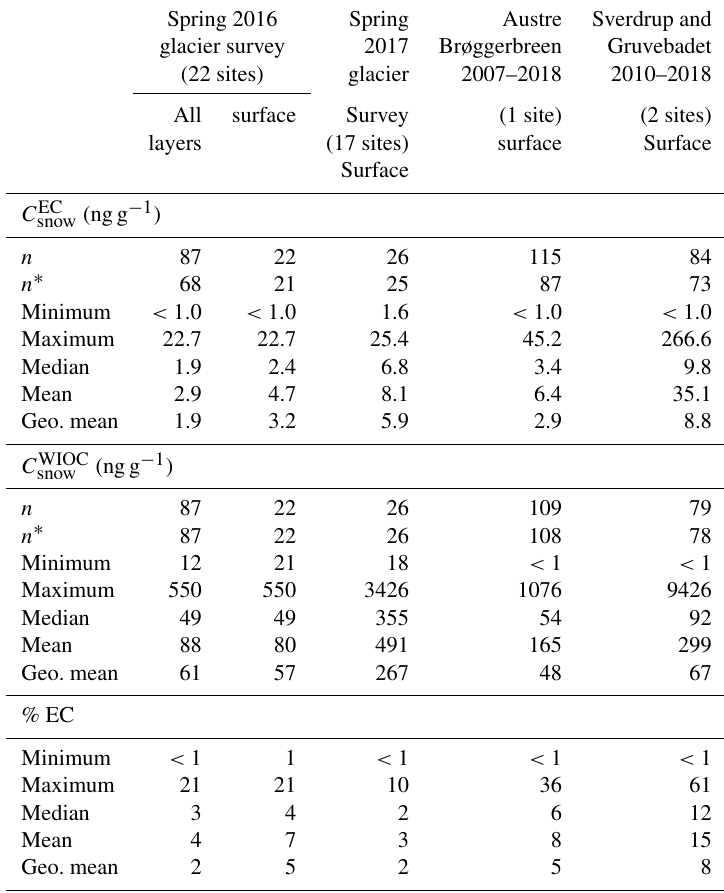
Table 3. Descriptive statistics for C EC snow , C WIOC snow and % EC in samples analyzed in this study. n ∗ is the number of values > 1ngg − 1 . Two outliers with C EC snow > 1700ngg − 1 were excluded from